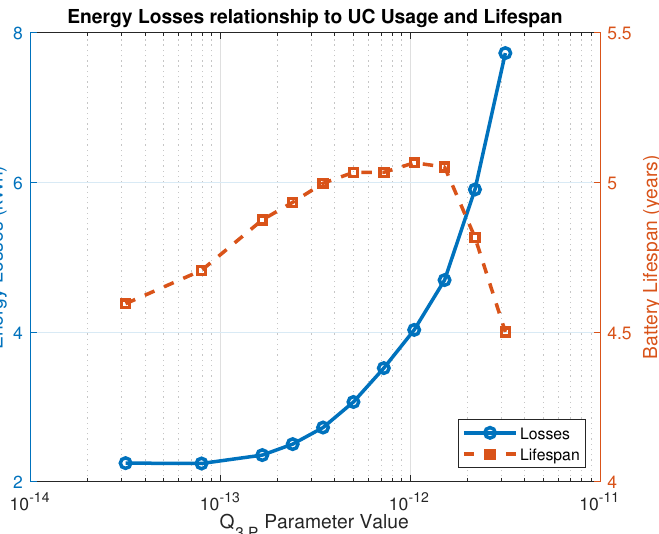
Figure 11. Comparison of energy losses (left axis) to battery lifespan (right axis) versus the Q 3, P weighting parameter, where increasing Q 3, P increases ultracapacitor